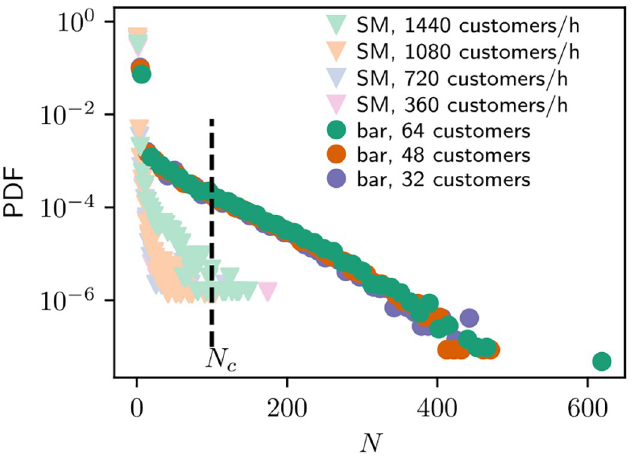
Fig 3. The distribution of accumulated exposure by healthy customers in supermarket simulations with varying customer density and in bar simulations with different number of seats.